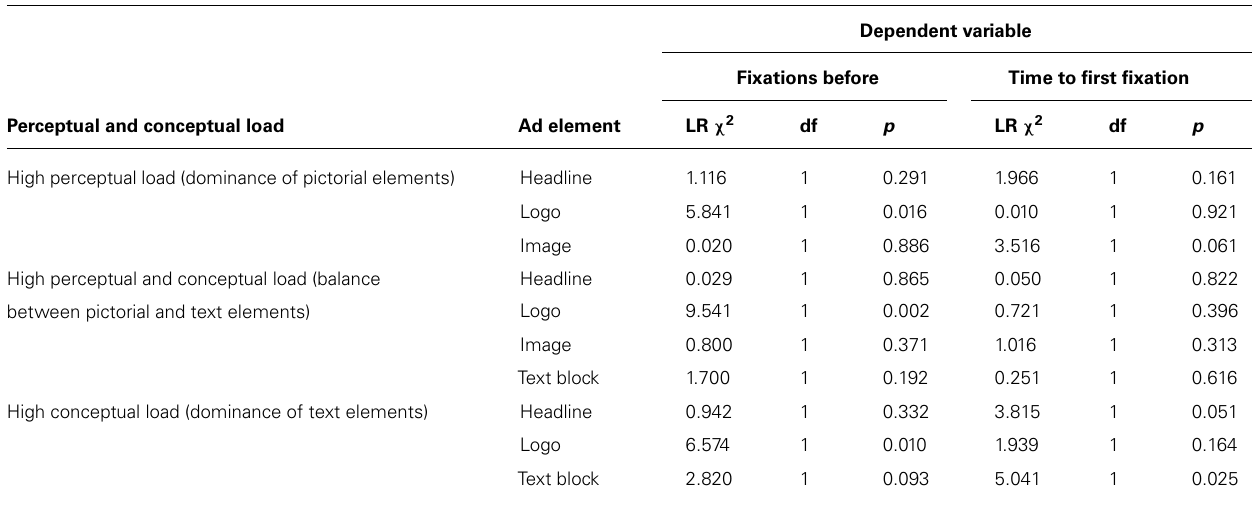
Table 1 | Effect of blood alcohol concentration on the visual salience of ad elements (headline, logo, image, text) under different levels of perceptual and conceptual